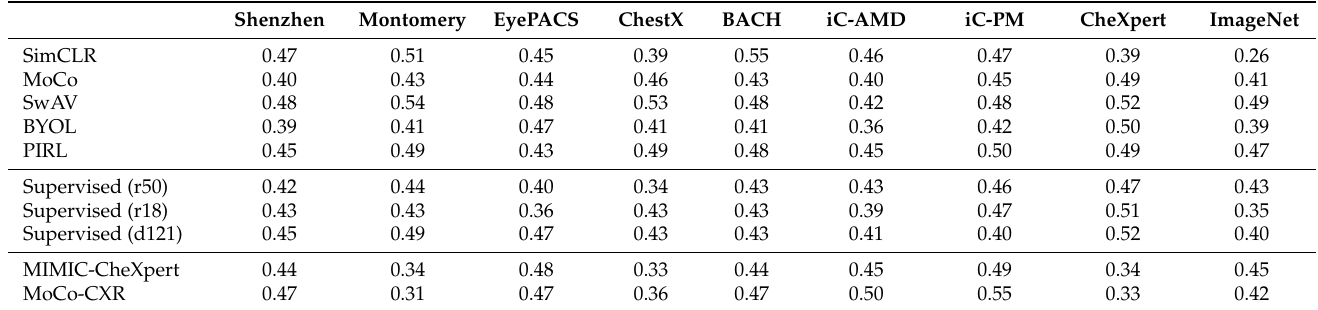
Table A7. Attentive diffusion values for the saliency maps for each model for each dataset. A low value close to 0 implies a narrow focus. The attentive diffusion corresponds to the proportion of the saliency map with value above the mean